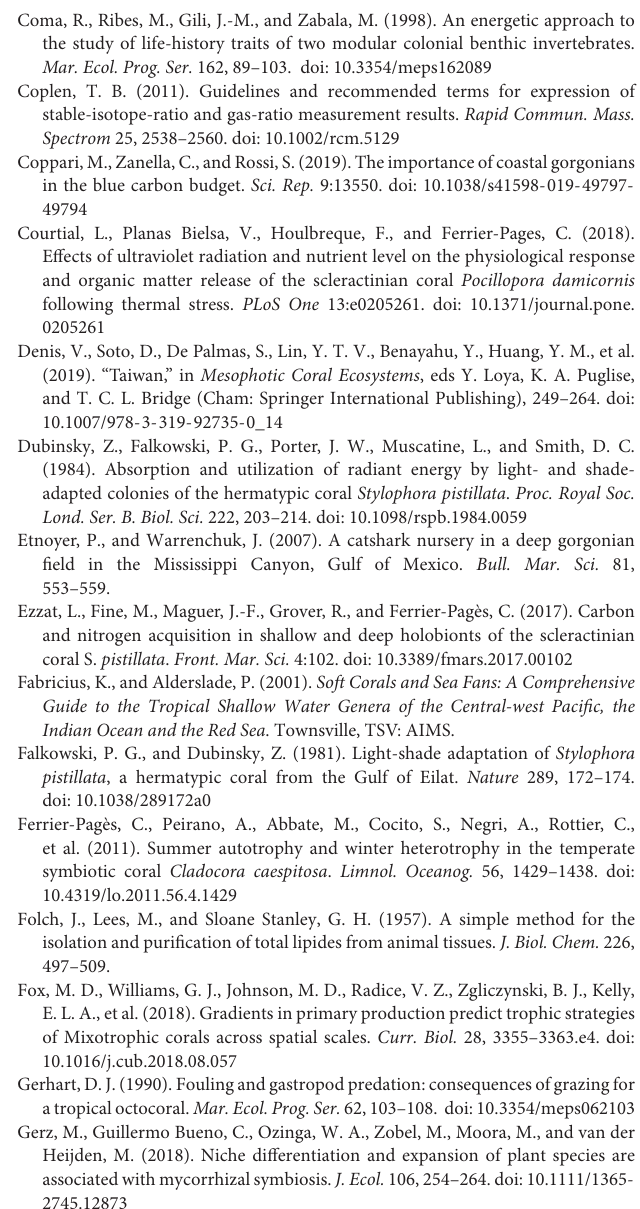
Supplementary Figure 1 | Pearson correlation matrix of trait values. Correlation coefficients ( r ) are provided with a color scale indicating either a highly positive (r = 1) or negative (r = − 1) correlation. Only significant and substantial correlations with a | r | > 0.8 were mentioned in the text. Non-significant coefficient ( p < 0.05) is shown crossed. Supplementary Table 1 | Samples examined for the identity of dominant algal symbiont and accession numbers for the corresponding sequences deposited in